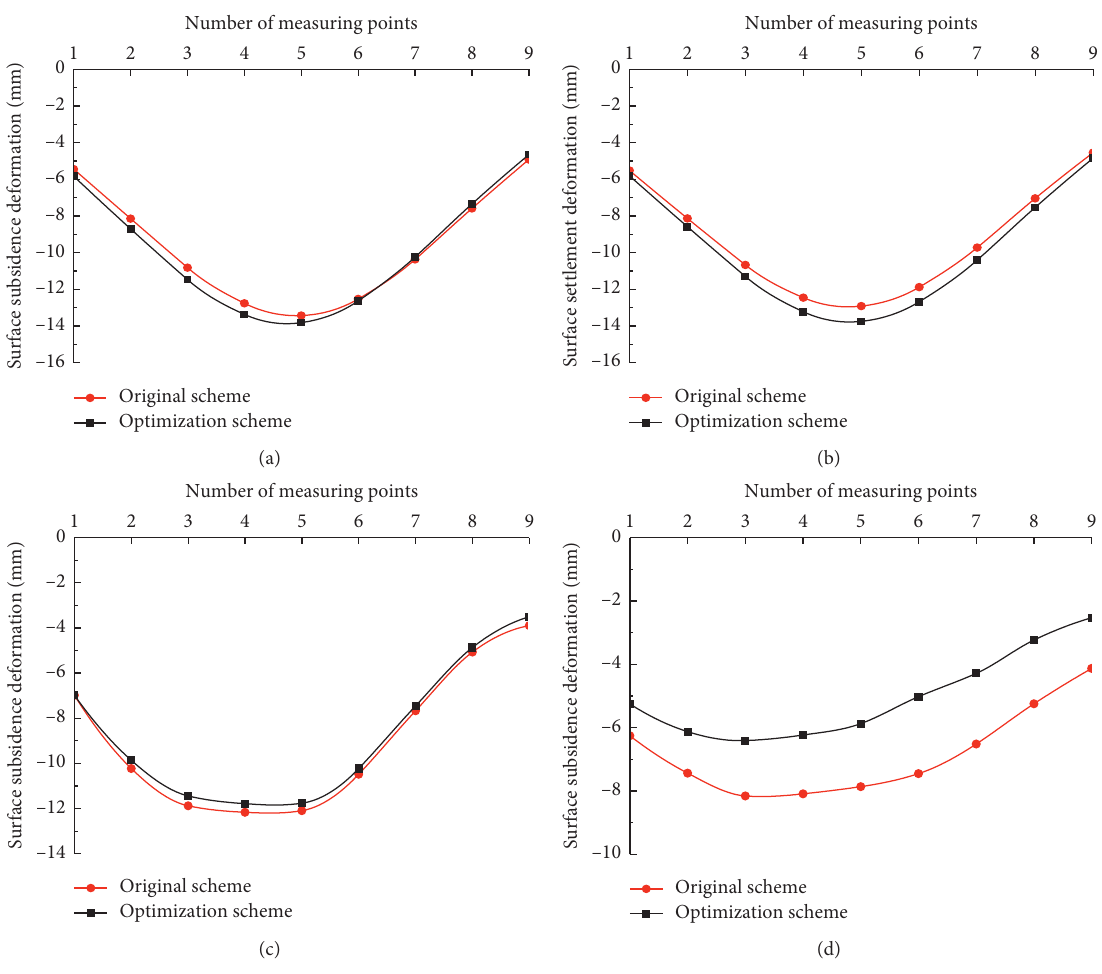
Figure 11: Comparative analysis of surface subsidence: (a) RK0+270; (b) RK0+280; (c) RK0+290; (d) RK0+300.